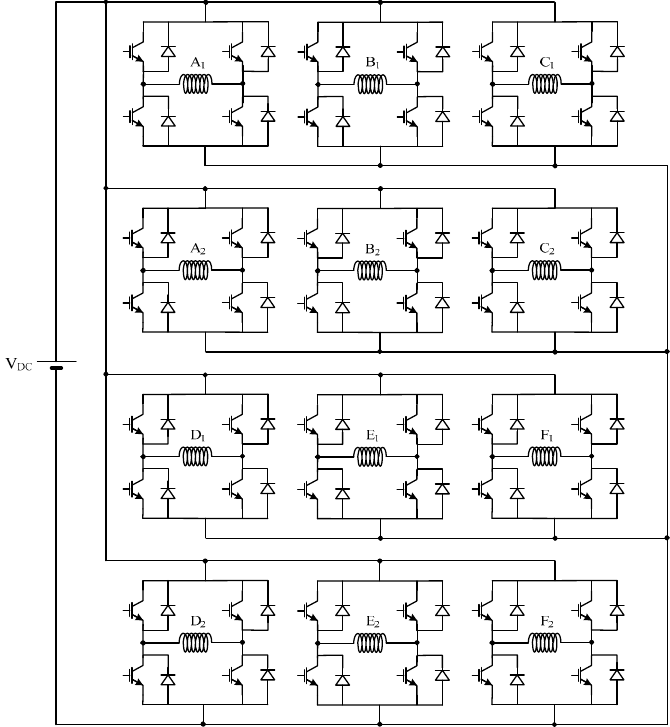
Figure 31. Fault-tolerant topology proposed by [96] based on using classic single-phase full-bridge (H-Bridge) converters for each phase coil. The solution requires 12 converters for a six-phase 12/8 SRM.